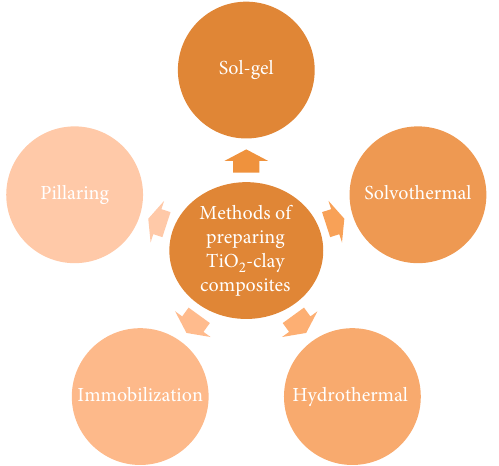
Figure 6: Methods of preparation of TiO [87 – 91].